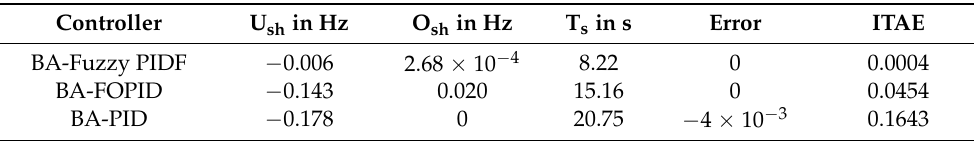
Table 16. Frequency response performance with different BA-tuned controllers designed via ITAE for scenario 2.